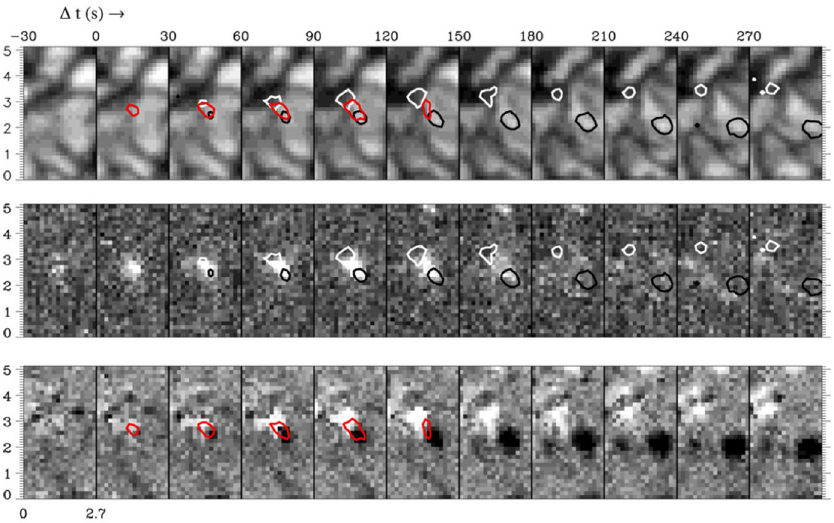
Fig. 16 Emergence of a small-scale magnetic loop as observed by the Hinode SP at a resolution of 0 . 32 (cid:2)(cid:2) . From top to bottom: continuum intensity, total linear polarization, and total circular polarization. The cadence of the observations is 30 s. Contours mark the position of the circular (black and white) and linear (red) polarization patches. Distances are given in arcsec. Image reproduced with permission from Martínez González and Bellot Rubio (2009), copyright by